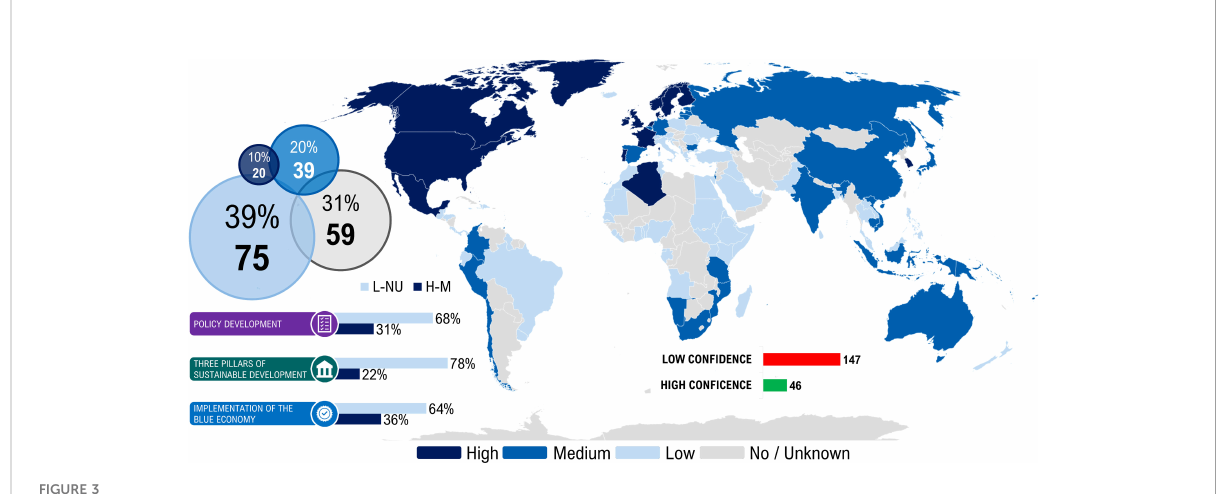
FIGURE 3 Global blue economy development